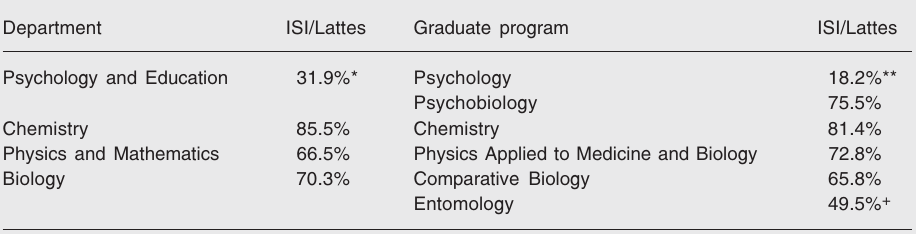
Table 3. Ratio between number of papers indexed by the Thompson Institute of Scientific Information (ISI) and the total number of papers in Curriculum Lattes for departments and graduate programs of the Faculdade de Filosofia, Ciências e Letras de Ribeirão Preto, USP.